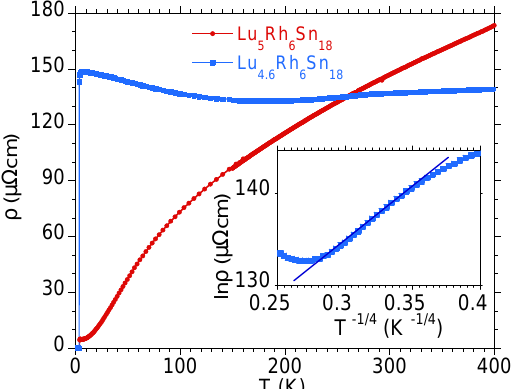
Figure 7. Electrical resistivity ρ ( T ) for Lu 5 Rh 6 Sn 18 (red points) and Lu 4.6 Rh 6 Sn 18 (blue points). Inset displays the resistivity data for Lu 4.6 Rh 6 Sn 18 in coordinates ln ρ = f ( T − 1/4 ) and the linear ln ρ vs. T − 1/4 behaviour between ∼ 60 K and ∼ 160